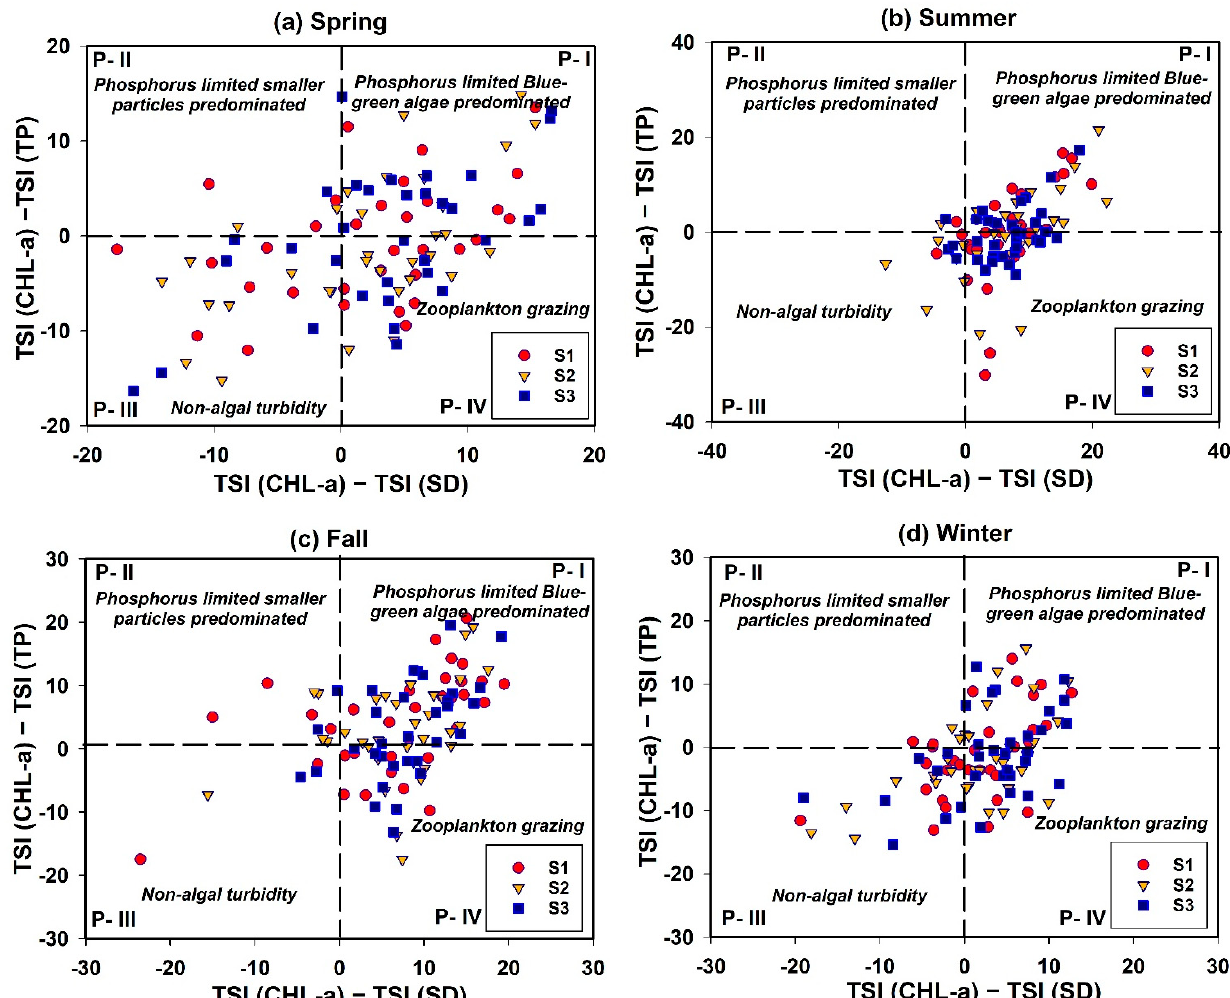
Figure 11. Seasonal trophic state index deviation (TSID) of Andong Reservoir (spring: March–May; summer: June–August; autumn: September–November, and winter: December–February).